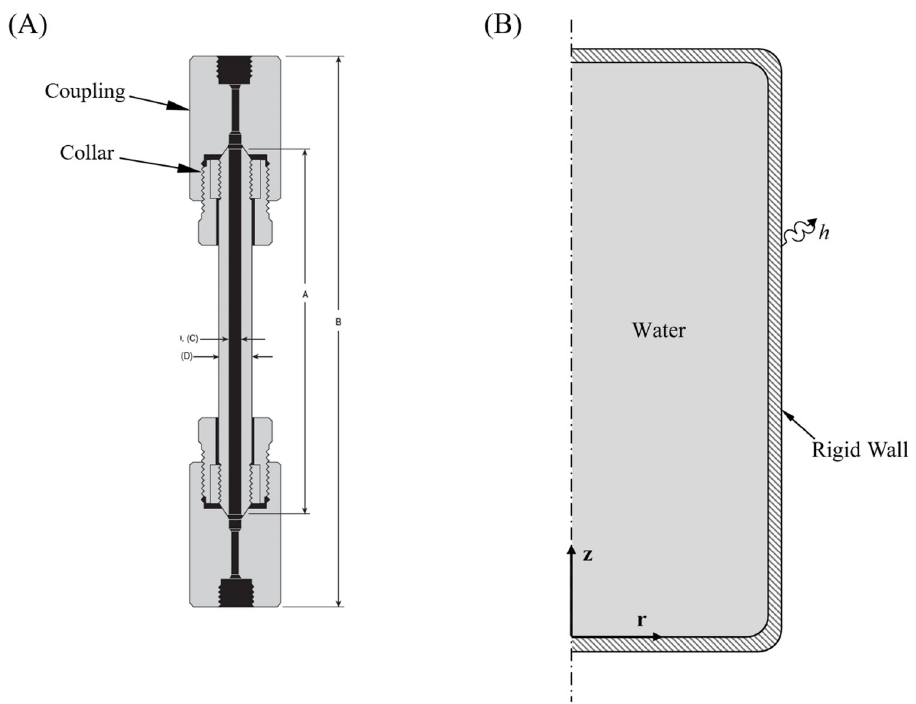
Fig 2. Illustration of the geometric models used in the current study. (A) An MS-1 microreactor (i.e., the isochoric chamber) used in a previous experimental study [12,19] and as a benchmark in the current study. (B) An idealized cylindrical isochoric container used for parametric studies (not drawn to